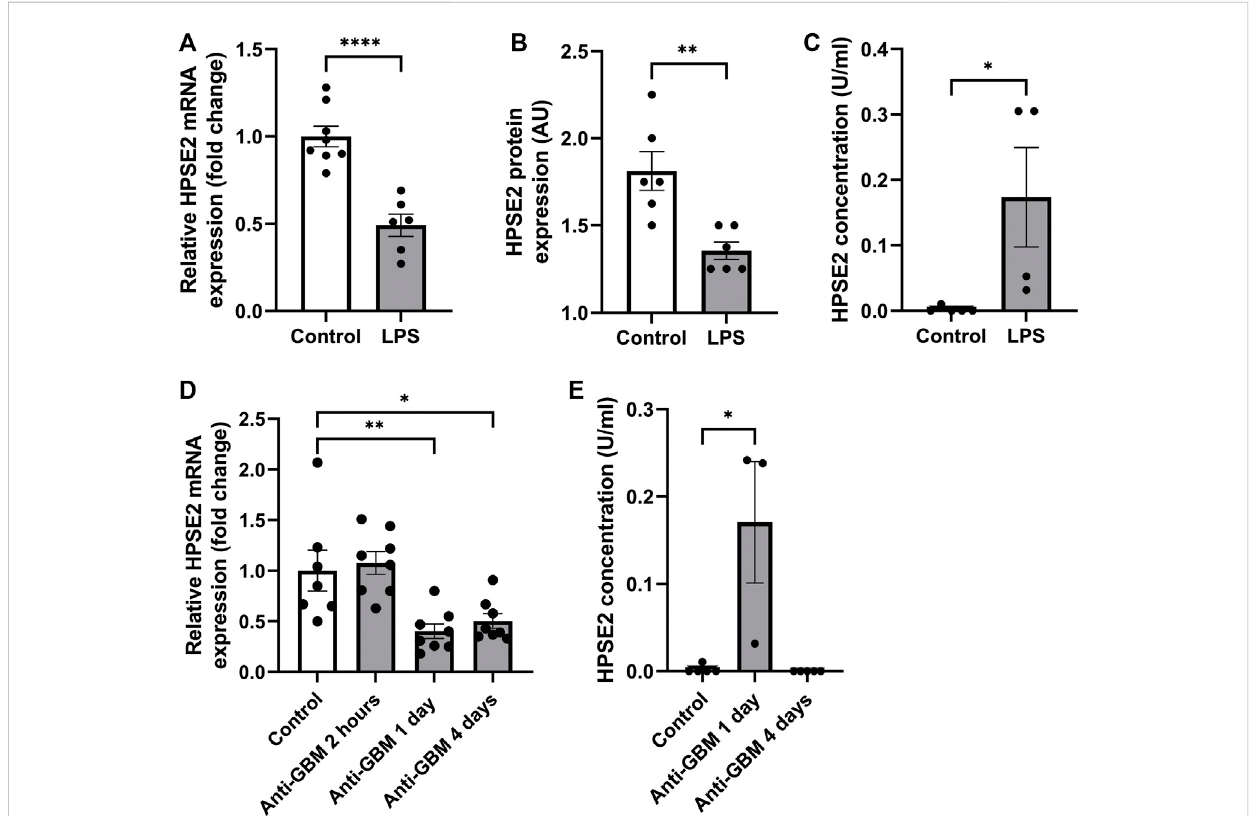
FIGURE 1 HPSE2 is downregulated in experimental glomerulonephritis (A) . Renal cortical HPSE2 mRNA expression of wild-type mice treated with or without LPS for 2 days (B) . Renal cortical HPSE2 protein expression of wild-type mice treated with or without LPS for 2 days (C) . HPSE2 concentration in urine of wild-type micetreatedwith orwithoutLPSfor 2 days (D) . Renalcortical HPSE2mRNA expression ofwild-type micetreated withor without anti-GBMfor 2 h, 1 day or 4 days (E) . HPSE2 concentration in urine of wild-type mice treated with or without anti-GBM for 1 day or 4 days. Data are expressed